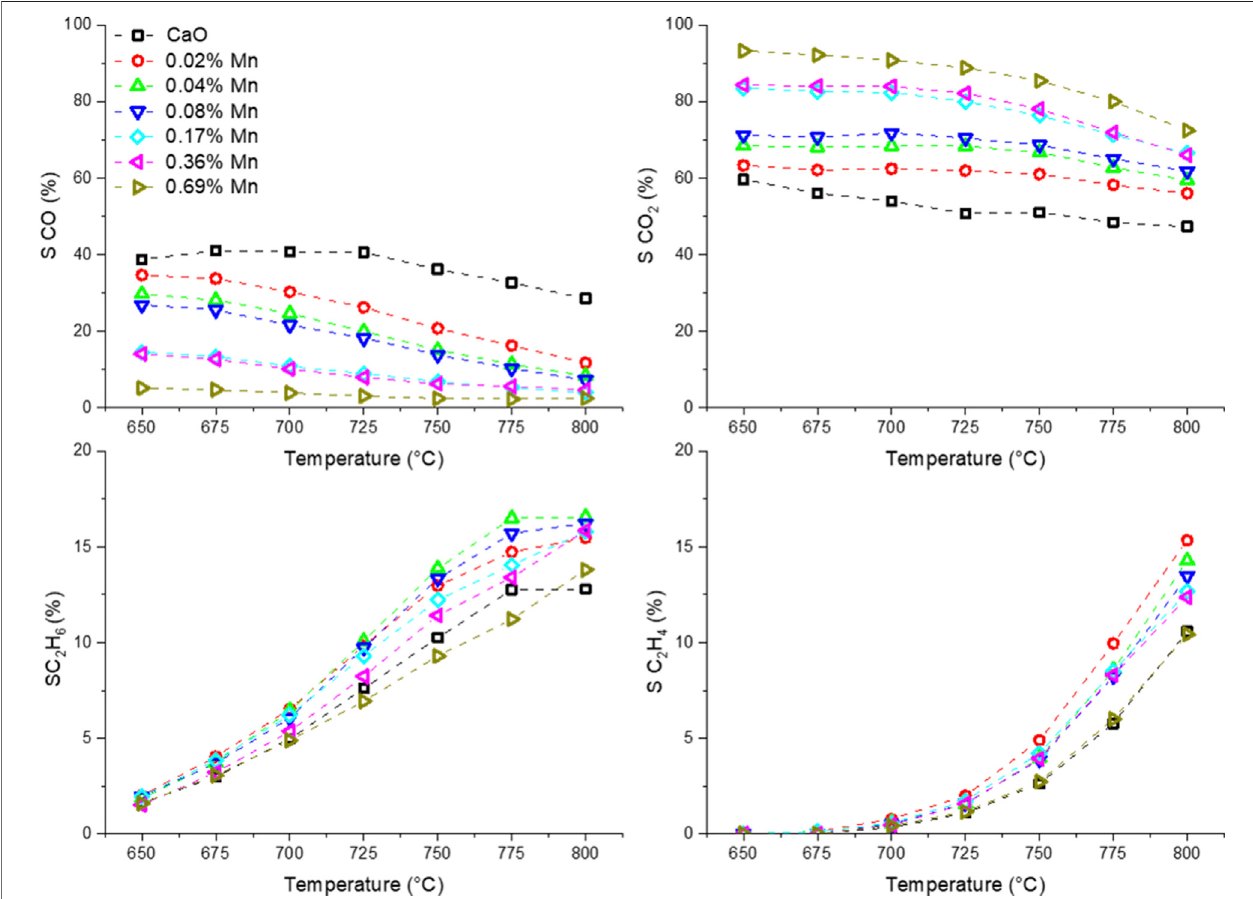
FIGURE 8 | Temperature dependence of OCM products using Mn-doped CaO catalysts (50 mg carbonate precursor, 750 mg SiC, 50 ml/min, CH 4 :N 2 :O 2 = 3: 3:1).